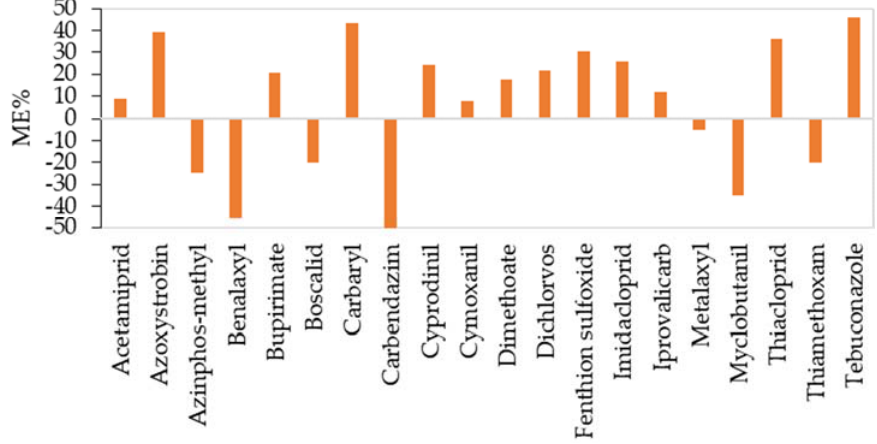
Figure 3. Matrix effects (%ME) calculated from the slopes of the solvent and matrix-matched calibration curves in milk.